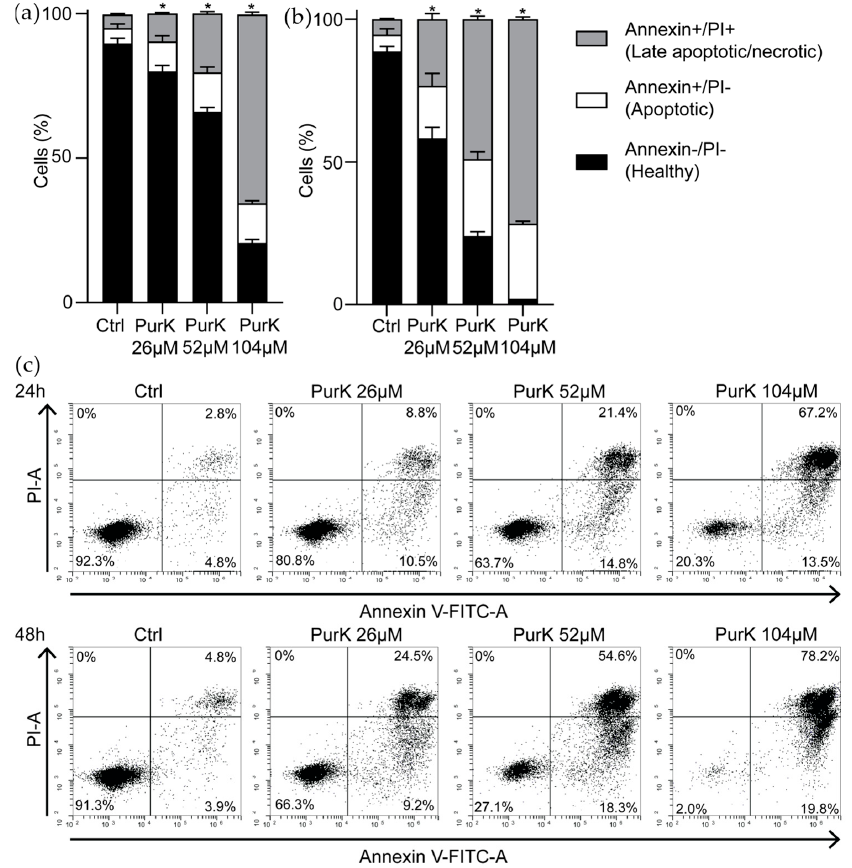
Figure 5. Apoptosis assay. Compound 1 ( PurK) increased apoptosis in MV-4-11 cells after 24 h ( a ) and 48 h ( b ) at 26 µM, 52 µM and 104 µM compound concentration (1 × IC 50 , 2 × IC 50 and 4 × IC 50 , respectively) when compared to control ( n = 3). At 104 µM of compound 1, the percentages of cells